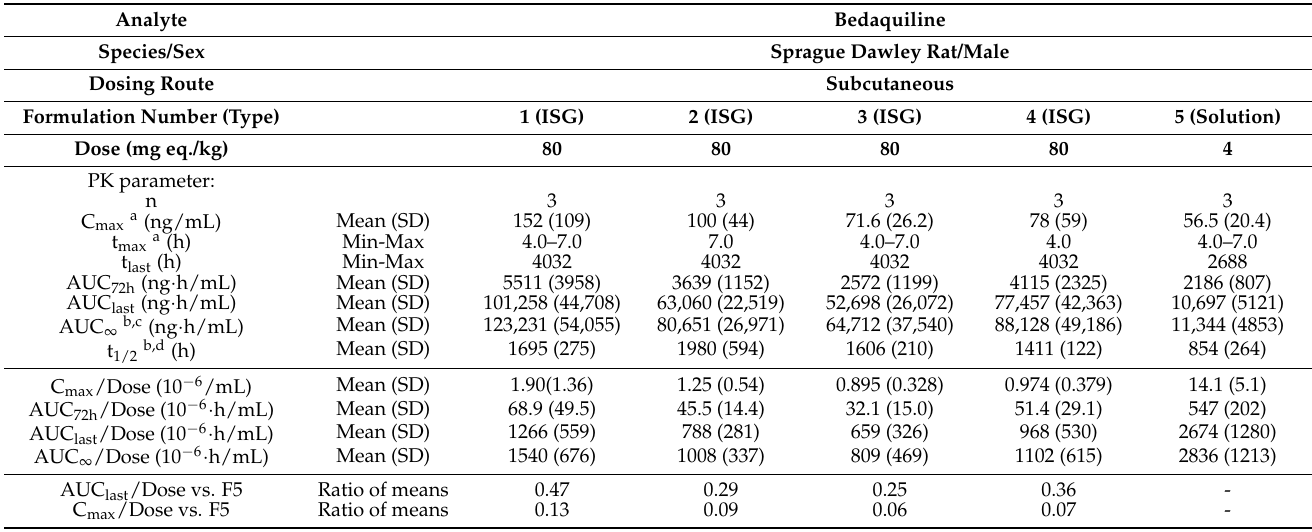
Table 3. Pharmacokinetic parameters in rat following subcutaneous administration of formulations 1 to 5.